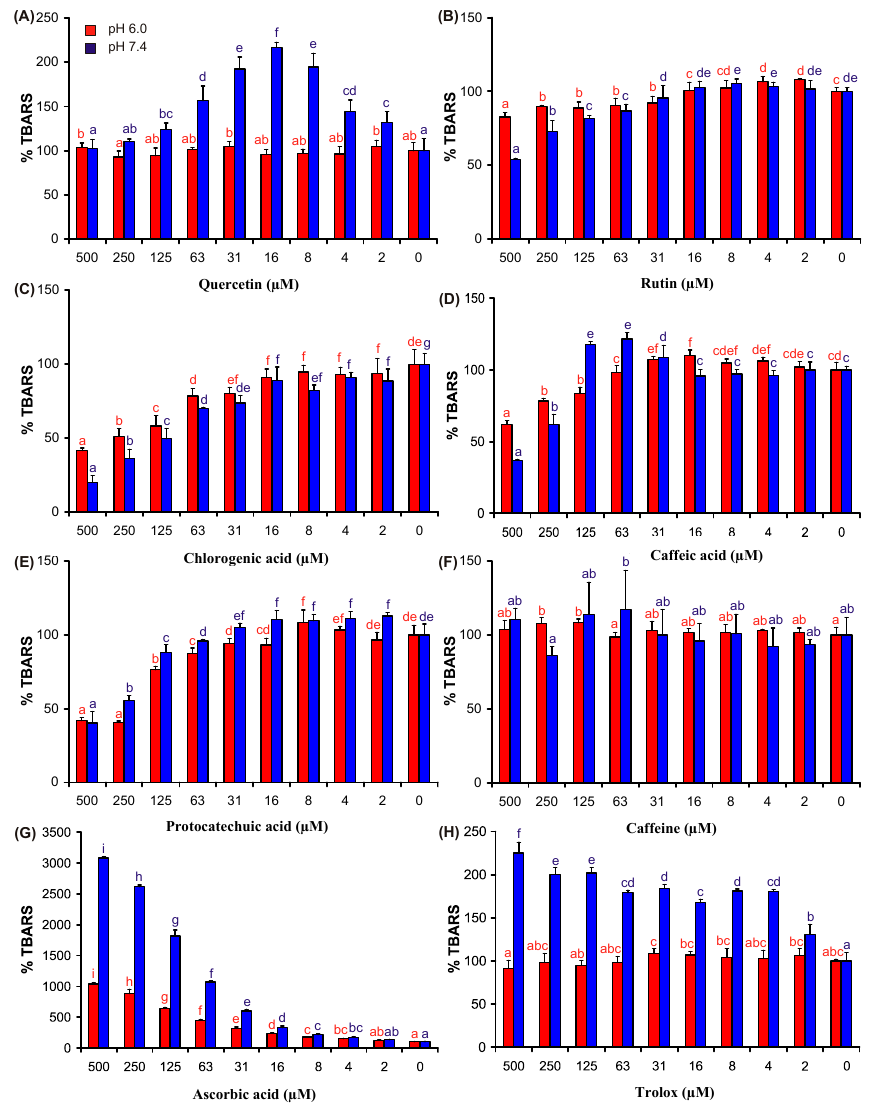
Figure 2. ROS generation in the Fe(II) autoxidation assay. Graphs ( A ) − ( H ) show activities of the tested compounds (A, quercetin; B, rutin; C, chlorogenic acid, D, caffeic acid; E, protocatechuic acid; F, caffeine; G, ascorbic acid; H, Trolox) in the assay. ROS were quantified as thiobarbituric acid reactive species (TBARS) arising from oxidative degradation of 2-deoxy- D -ribose. The results are presented as TBARS levels relative to the control (100% = TBARS of the control reaction mixture without test compound). The final concentration of Fe(II) in the reaction mixture was 10 µM. Error bars indicate standard deviation of three replicates; letters (a − i) indicate different levels of significance (95% Duncan), for details see Experimental